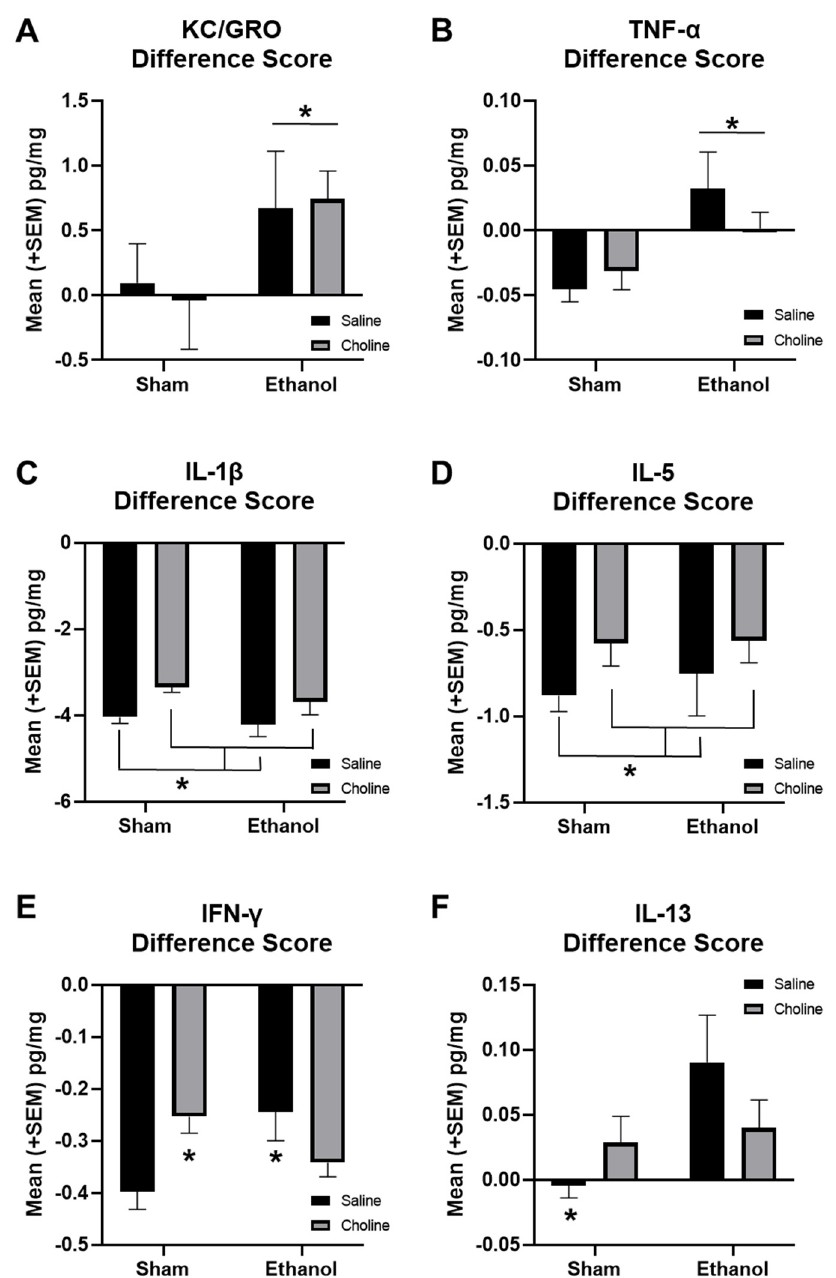
Figure 8. Developmental EtOH exposure and choline supplementation alter cytokine levels across development. Difference scores from adolescent to adulthood are used to show change in cytokine levels across development for ( A ) KCGRO (EtOH > Sham, * p < 0.05), ( B ) TNF- α (EtOH > Sham, * p